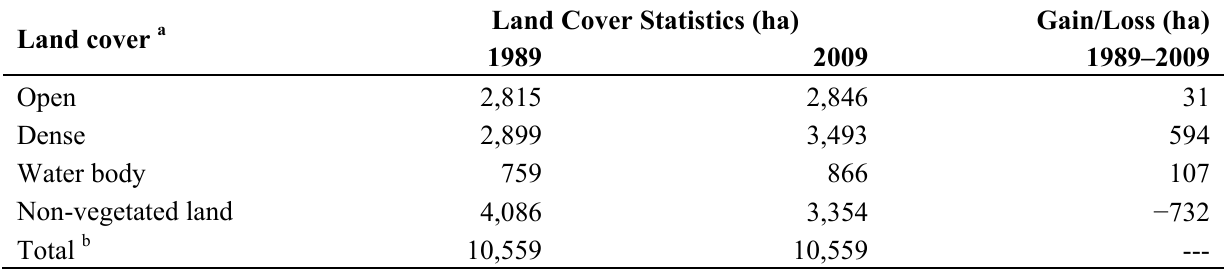
Table 4. Statistics of the land cover classes in the City of San Fernando.